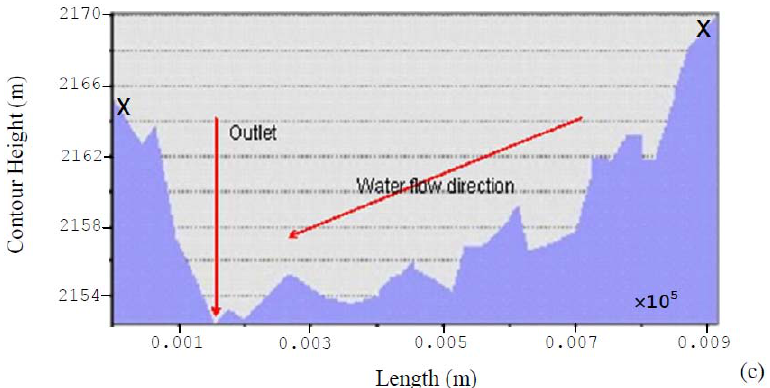
Figure 11. Cross-sections along: ( a ) the proposed dam axis A-A; ( b ) longitudinal section (Y-Y) of the center of the dam site (length of the dam); and ( c ) the dam throwback or fetch (X-X) at 3 m × 3 m spatial resolution.